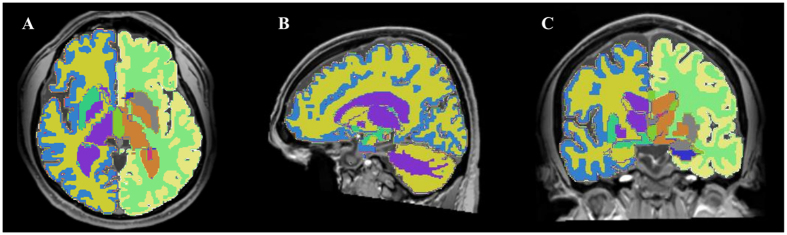
Labeling example of brain regions.(A) Axial, (B) Sagittal, (C) Coronal. Each color represents a different region label. Non-brain tissues (e.g., skull) are shown here for visualization purposes.